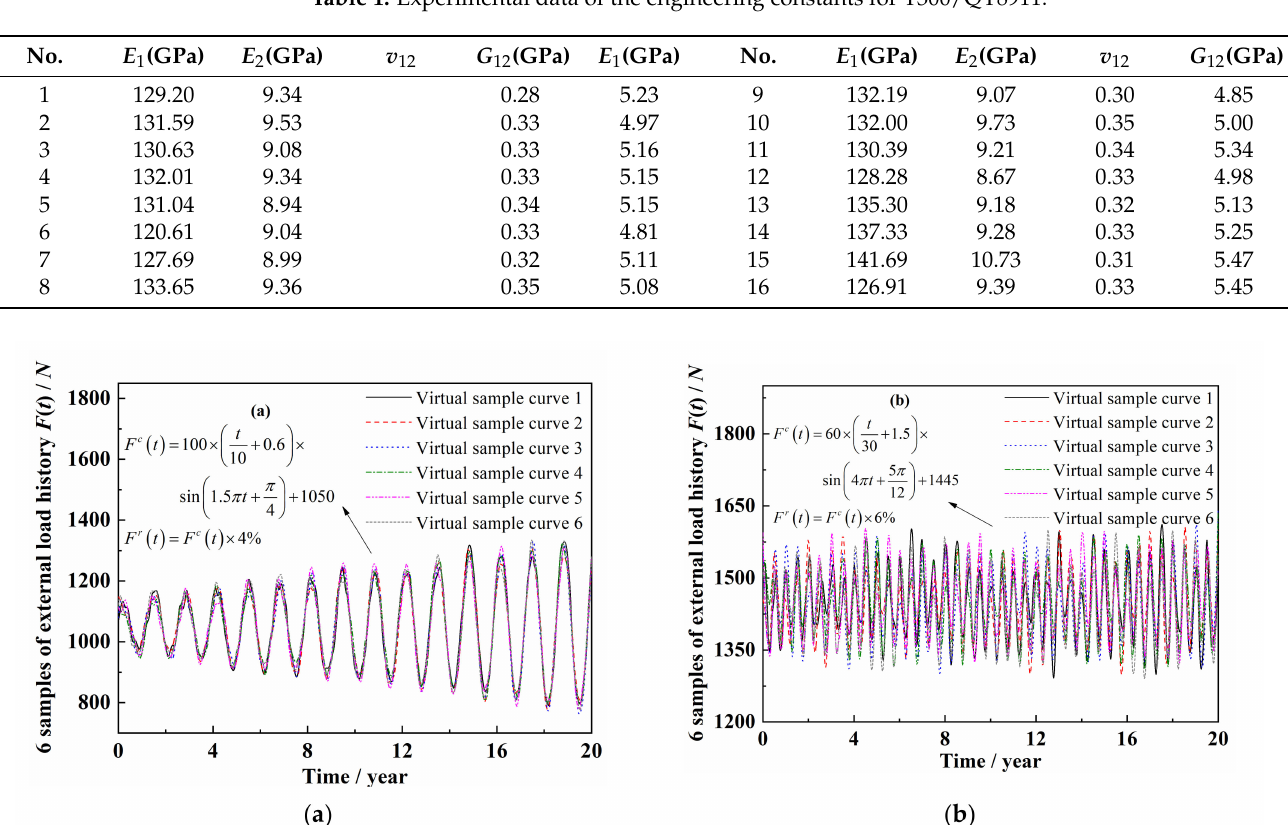
Table 1. Experimental data of the engineering constants for T300/QY8911.